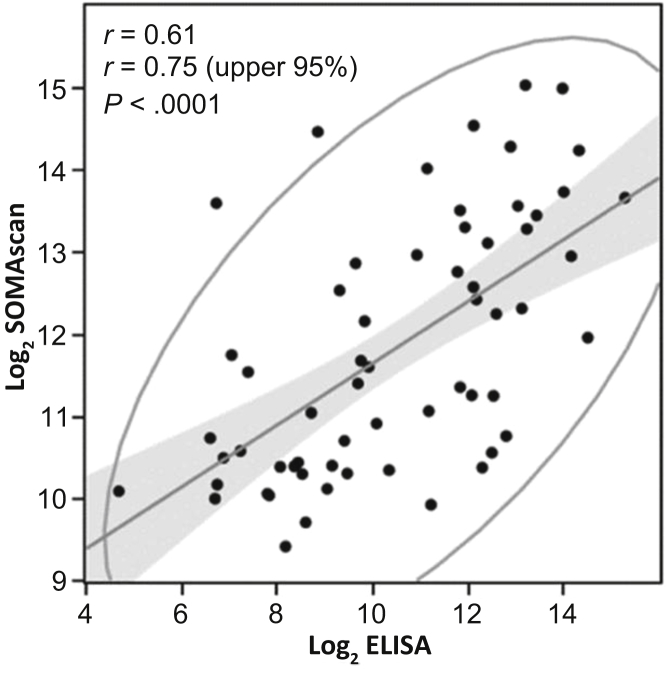
Correlation plot between Log2 slow off-rate modified aptamers (SOMA) scan values and Log2 C-terminus enzyme-linked immunosorbent assay (ELISA) for serum fibroblast growth factor 23 (FGF23) levels. The ellipse is for confidence coefficient of 95%, within which 95% of the samples (points) were enclosed. The correlation fit line is also shown.